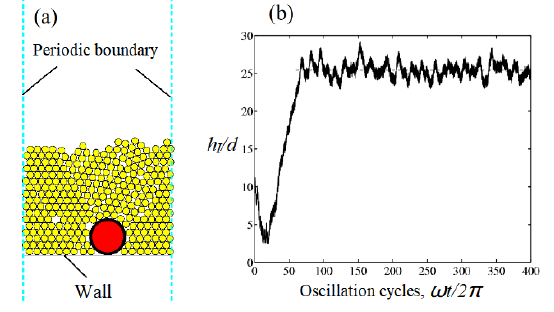
Fig. 1. (a) Shishodia’s simulation model; (b) A plot of the